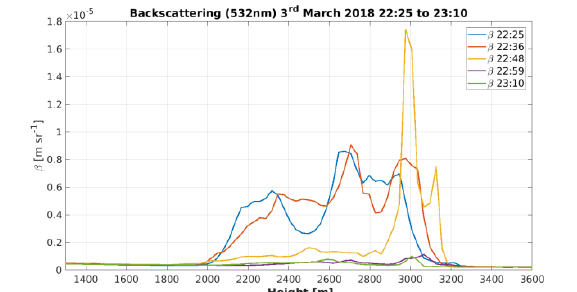
Fig.04: Backscattering in a time range of ±25min where the radiosonde (22:45UTC) was